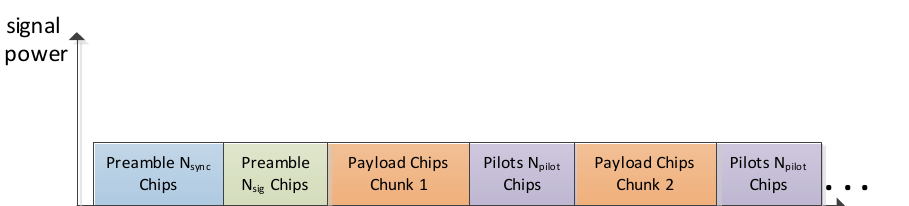
Figure 3. ICARUS uplink bust structure.